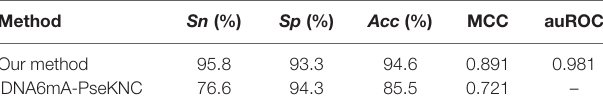
TABLE 4 | Comparison of different methods for predicting 6mA sites in independent dataset. Method